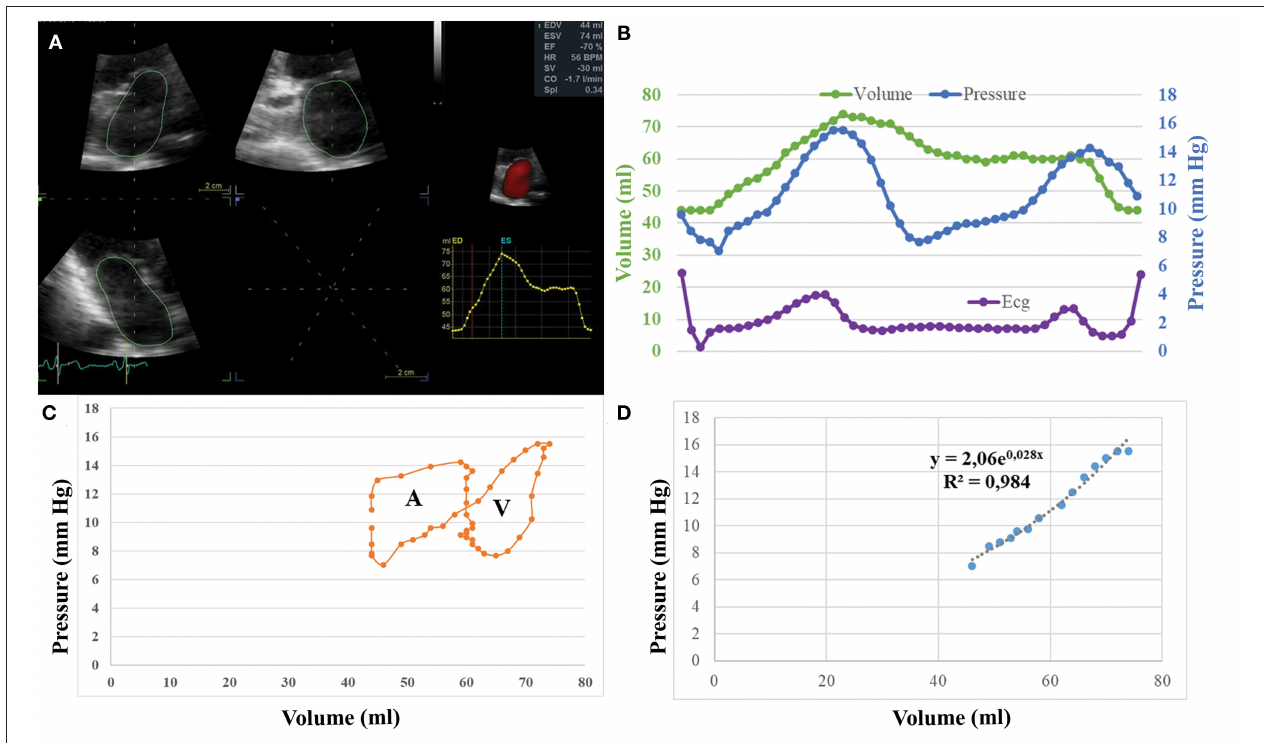
FIGURE 1 | (A) Methodology of echocardiographic analysis for left atrial (LA) volume calculation. (B) Simultaneous recording of LA pressure and LA volume during a cardiac cycle gated by ECG. (C) Graphical plotting of LA volume vs. LA pressure and creation of volume pressure loops. (D) Calculation of the passive elastic chamber stiffness constant (cm − 3 ) and of the elastic constant